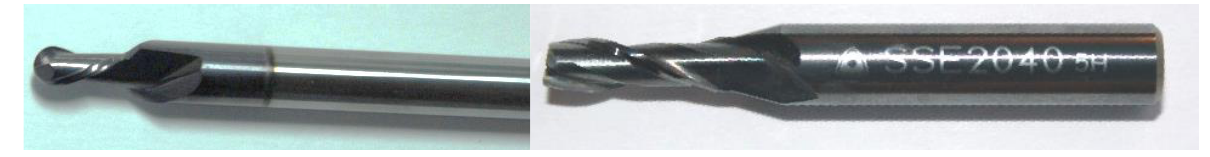
Figure 7. Cutting milling tools used in the machining process.